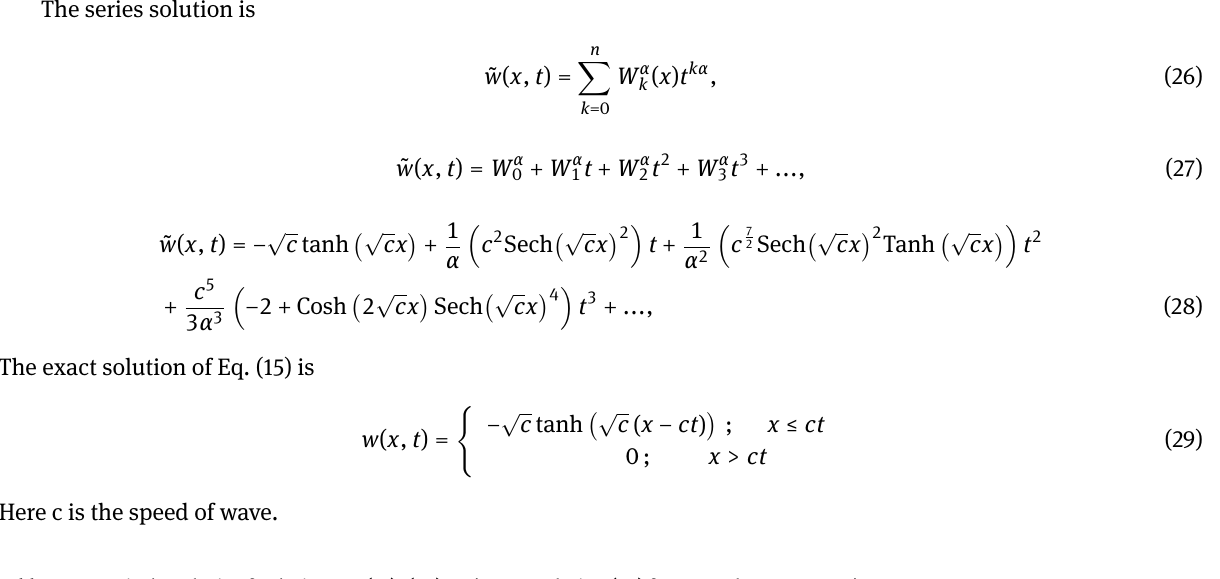
Table 1: Numerical analysis of solution Eq. (21), (28) and exact solution (29) for example 1 at c=1 and α